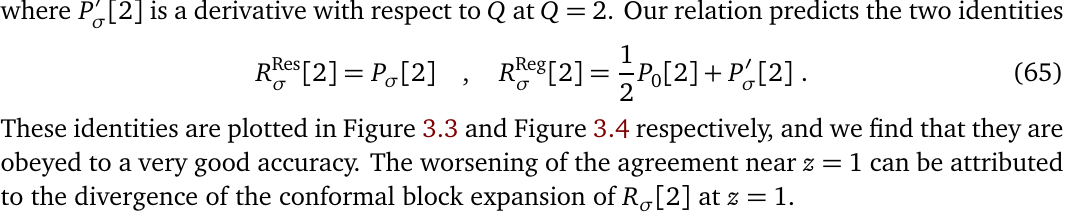
Figure 3.2: Comparing R tivities (crosses) for Q = 2.5. We plot these quantities as functions of z 2 ( 0,1 ) , and find that Eq. (61) is obeyed. The inset shows the relative differences which are O ( 10 (cid:0) 4 ) for most values of z